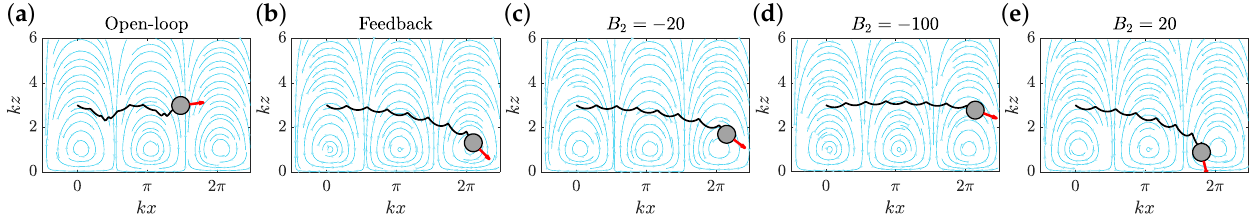
Figure 5. Effect of feedback control and wall interactions on the controlled trajectories. All panels show the trajectory of the swimmer starting at ( 0,3, − π /2 ) until T = 5 with various parameter control policies (always with u max = 5). The grey circle and red arrow respectively represent the swimmer and its orientation at the end of its motion. Panel ( a ) displays the trajectory obtained with the open-loop control policy defined in Equation (18), aimed at reproducing the optimal control determined in the previous section. The trajectory shows a bad synchronisation with the background flow, with little improvement of the swimmer’s average horizontal speed compared with the free swimming case. A feedback control policy is used in panel ( b ), defined as in Equation (19). The feedback helps recover synchronisation, but the swimmer’s orientation slowly changes, with risk of crashing into the wall. Panels ( c – e ) show the effect of the wall interaction term B 2 under the same feedback control policy. When B 2 < 0 (puller), as on panels ( c , d ), repulsion from the wall reduces the risk of crashing, all the more so the larger | B 2 | is; on the contrary, if B 2 > 0 (pusher), the swimmer is attracted to the